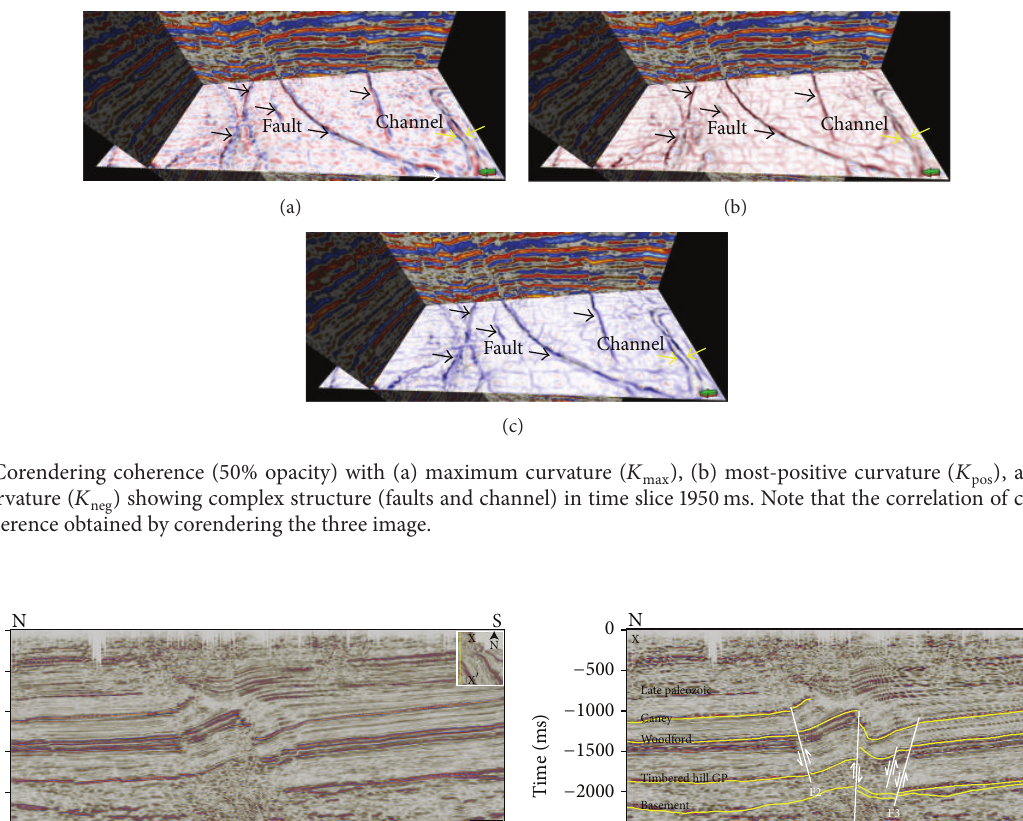
Figure 8: (a) Maximum curvature (𝐾 max ) , (b) most-positive curvature (𝐾 channel with differential compaction.